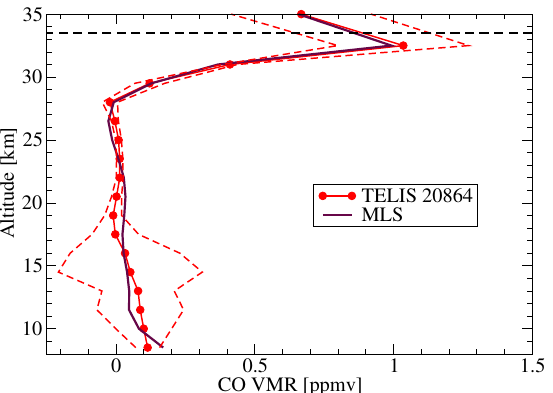
Figure 15. Comparison of CO retrievals from TELIS and MLS on 24 January 2010. The lowest tangent height of TELIS is 10km and the retrieval results below this altitude have little physical meaning. The solar zenith angles of the MLS and TELIS data are 84.0 ◦ and 85.8 ◦ , respectively. The time difference of the TELIS and MLS measurements was less than 0.5h.